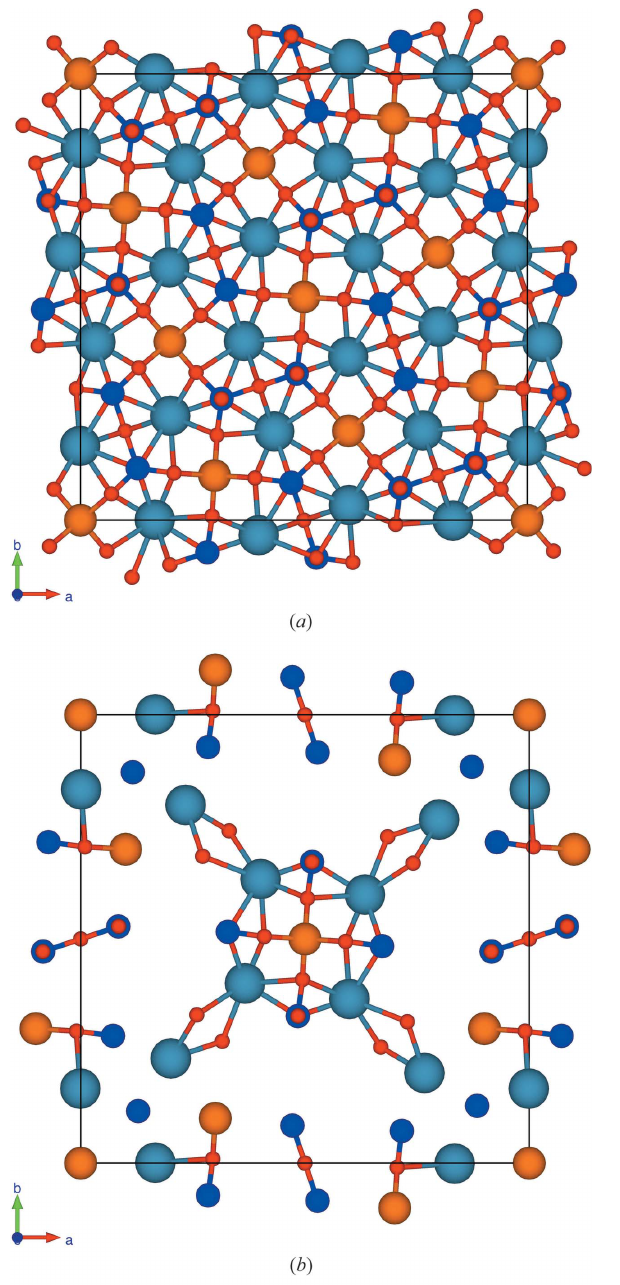
Figure 1 View of the unit cell of the twin lattice of melilite along the c axis. The atoms of type X (mainly calcium in our example) are coloured light blue, the atoms of type Y (mostly magnesium) in orange, the atoms of type Z (mainly silicon) dark blue and the oxygen atoms are in red. ( a ) View of all atoms in the cell and ( b ) the quasi-restored atoms.